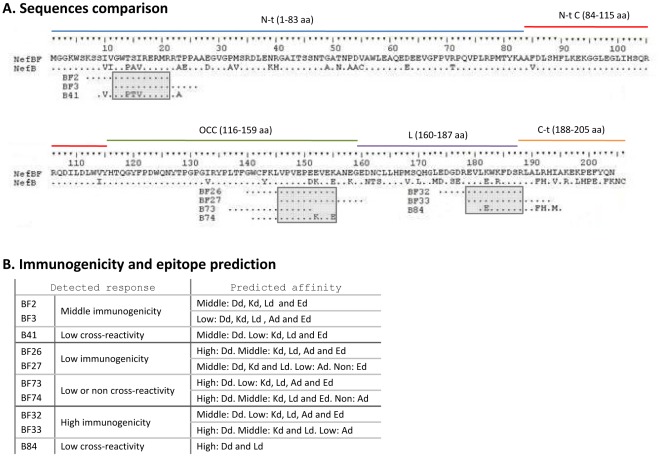
Sequence analysis and localization of B and BF peptides targeted.
A) Comparison between amino acid sequences of NefBF and NefB proteins, and BF and B peptides targeted. Grey boxes indicate the overlapping peptide sequences between the BF recognized peptides, suggesting the potential epitope. B) Peptide immunogenicity of the response found is compared with the predicted MHC affinity. Prediction analysis were made with the SYFPEITHI Epitope Prediction (Class I: Ld and Kd; Class II: Ad and Ed) and PREDEP (Class I: Dd) prediction softwares.